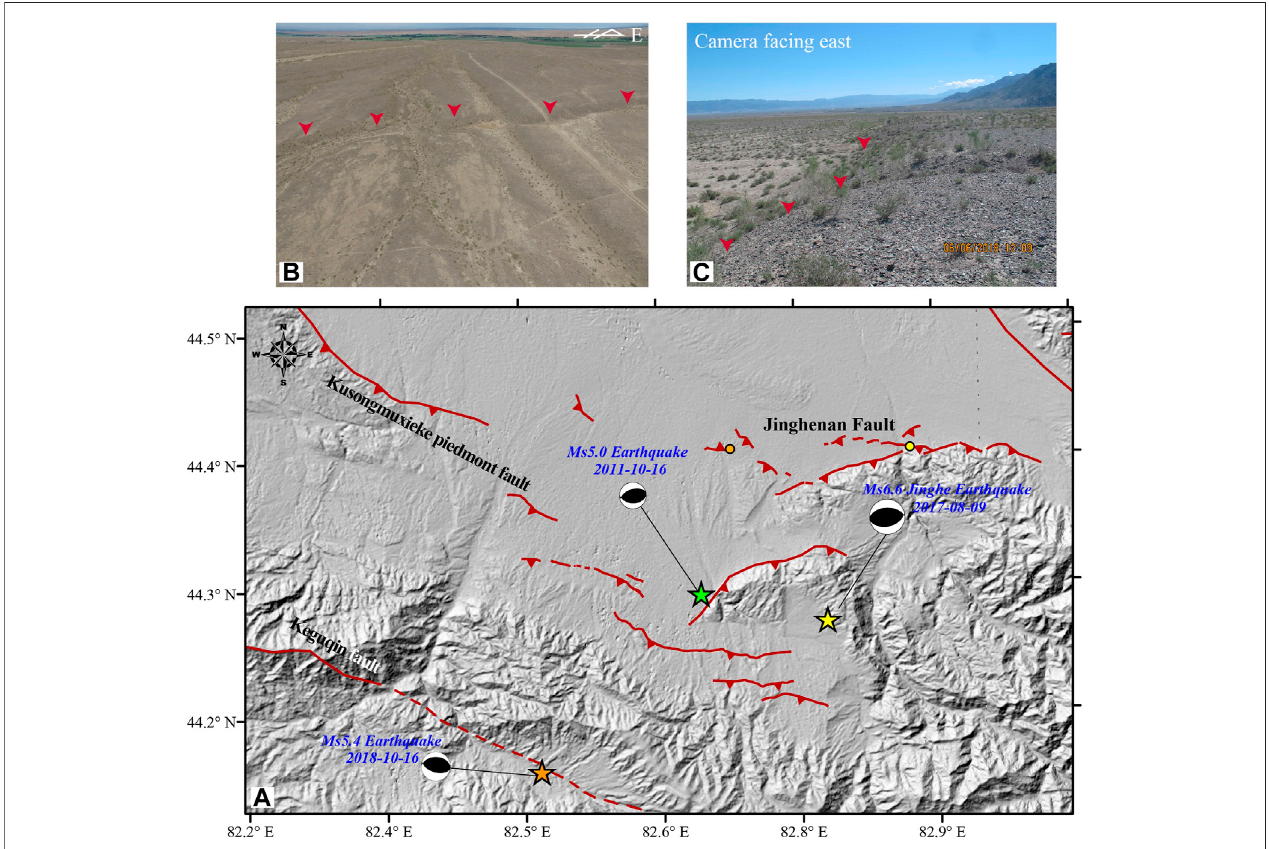
FIGURE2|(A) MapproducedafterageologicalinvestigationoftheJinghenanfaultsuperimposedontopographicrelief.Thesolidlineswithtrianglesdenoteactive thrust faults. The dashed line is the speculative extension. The focal mechanism solutions represent the three recent earthquakes ( M ≥ 5.0). The yellow star marks the location of the earthquake on August 9, 2017. The orange star marks the location of the earthquake on October 16, 2018. The green star marks the location of the earthquake on October 16, 2011. (B) Photograph ofthe Jinghenan fault reversescarp taken by an unmanned aerial vehicle at the position of the orange dot in (A) . Red arrows indicate the scarp. (C) Photograph of the Jinghenan fault scarp taken with a handheld camera at the position of the yellow dot in (A) . Red arrows indicate the scarp.